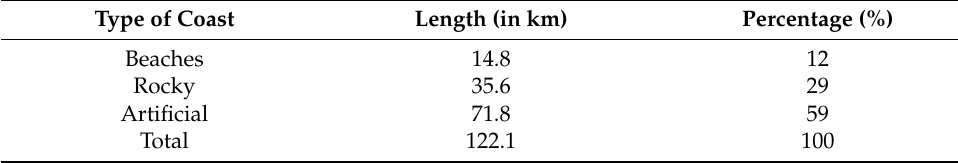
Table 1. The type of coasts, their length and